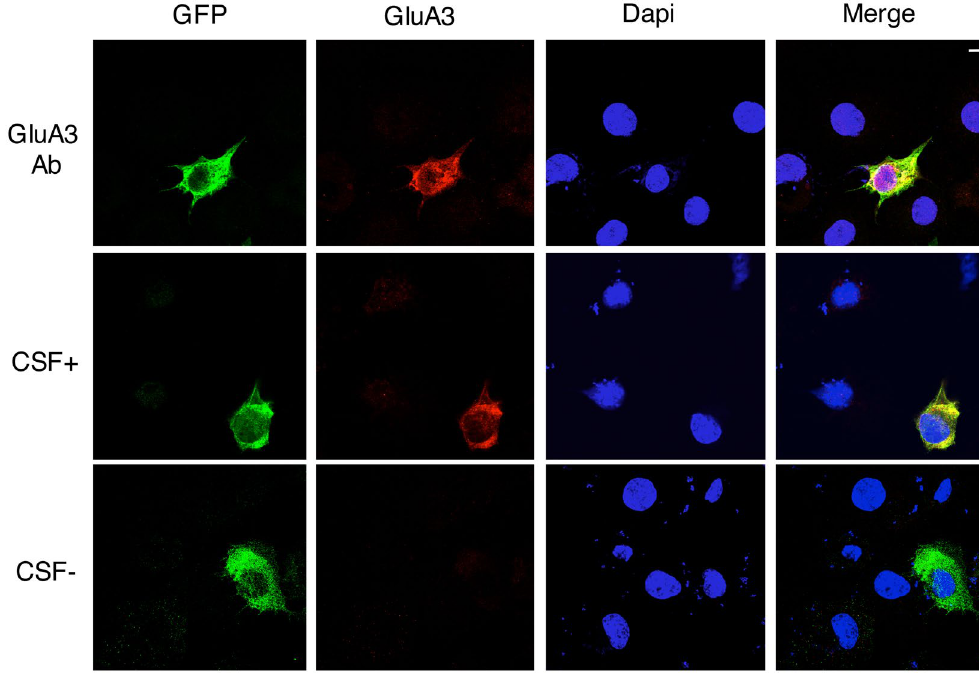
Figure 3. Cell-based assay in heterologous COS7 cell. Confocal imaging of COS7 cells transfected with rat GluA3-GFP (green) and incubated with a GluA3 commercial antibody (upper panels), CSF + (middle panels) or CSF − (lower panels) for the staining of GluA3 (red). Dapi was used to recognize cell nuclei (blue). Merge panels are shown on the right. Scale bar, 10 μ